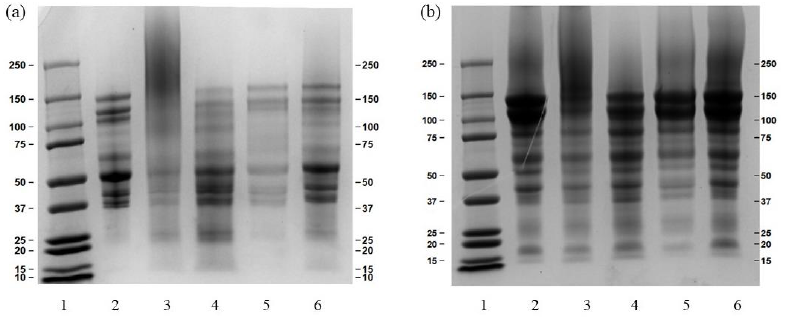
Figure 3. The SDS-PAGE of extracted protein (( a ) was 55 °C and ( b ) was 85 °C) re-heated at 100 °C for 30 min. 1 were marker; 2 were the extracted proteins; 3 were the extracted proteins re-heated at 100 °C; 4, 5, and 6 were the extracted proteins re-heated at 100 °C with 1% SDS, 8M urea, and 1% β -mercaptoethanol, respectively.